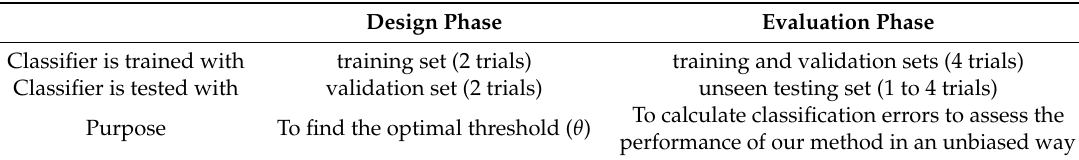
Table 2. Summary of the details of the design and evaluation phases.